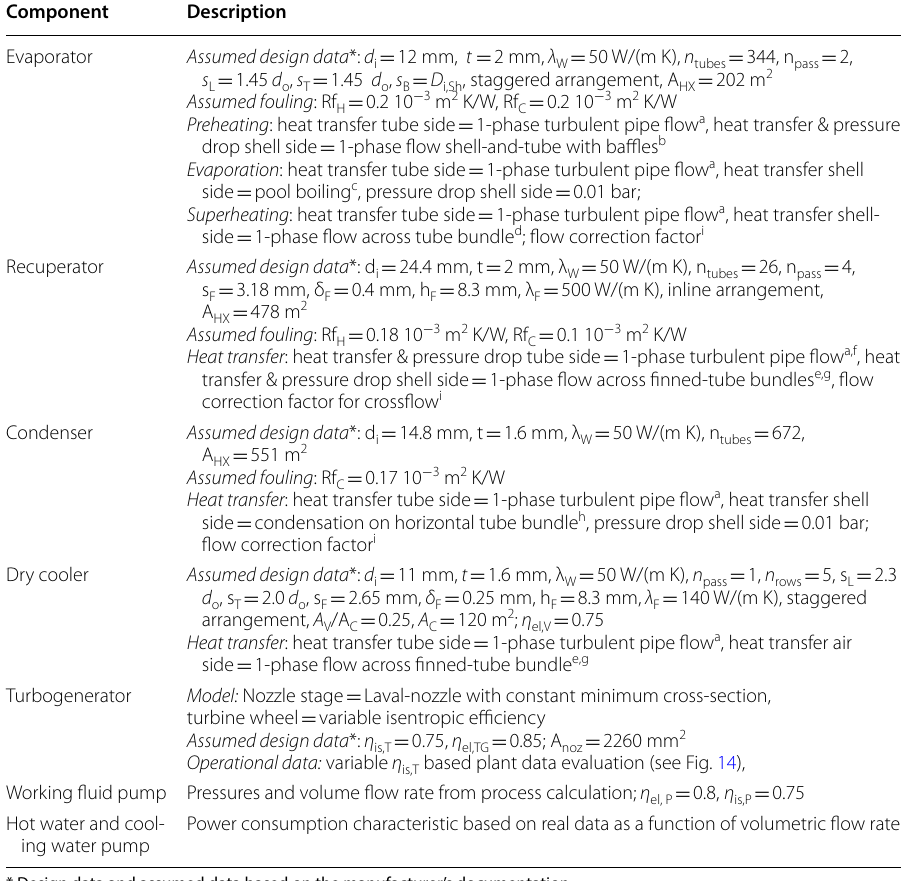
Table 3 Description of the modeled plant